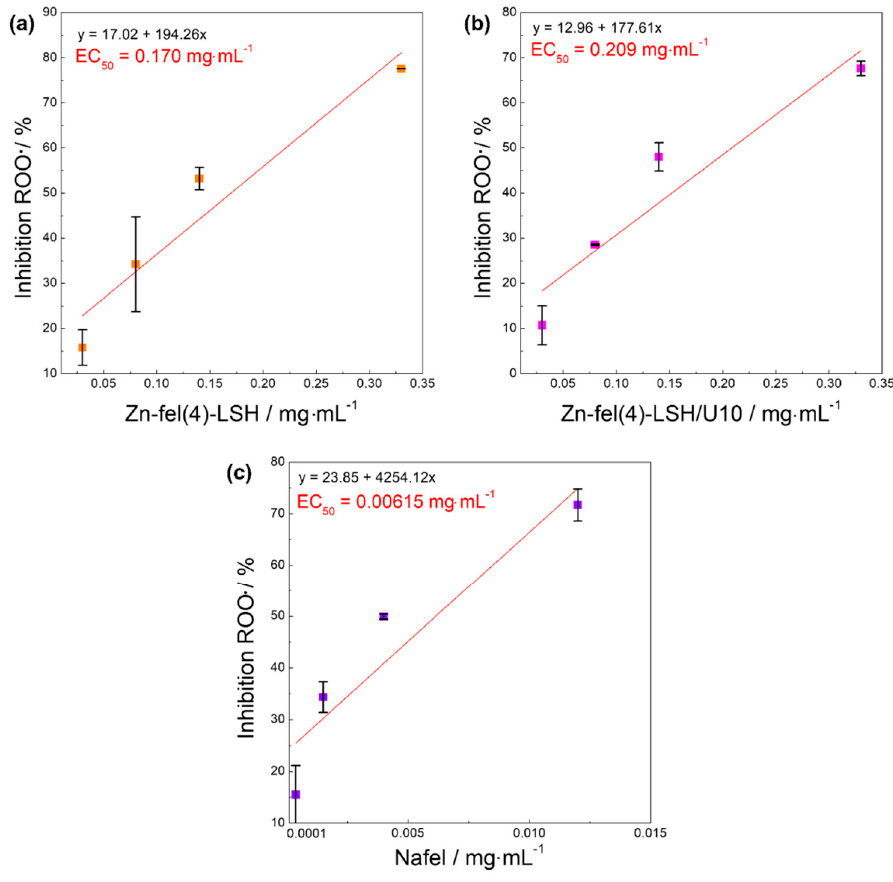
Figure A8. Inhibition (capture) of ROO • reactive species by ( a ) Zn-fel(4)-LSH, ( b ) Zn-fel(4)-LSH/U10 and ( c ) Nafel (NaC 10 H 9 O 4 ) samples.